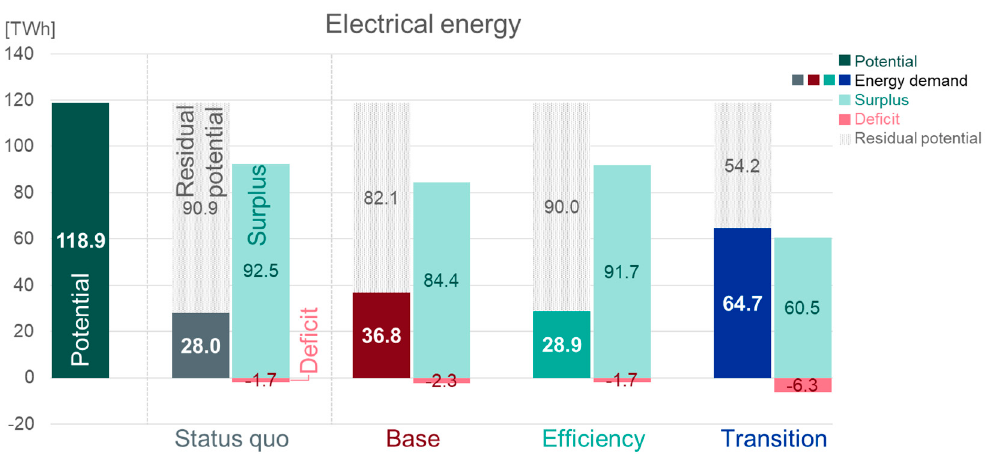
Figure 5. Electrical energy—detailed analysis of potential as well as demand and coverage per scenario based on the comparison of load and generation profile in hourly resolution.